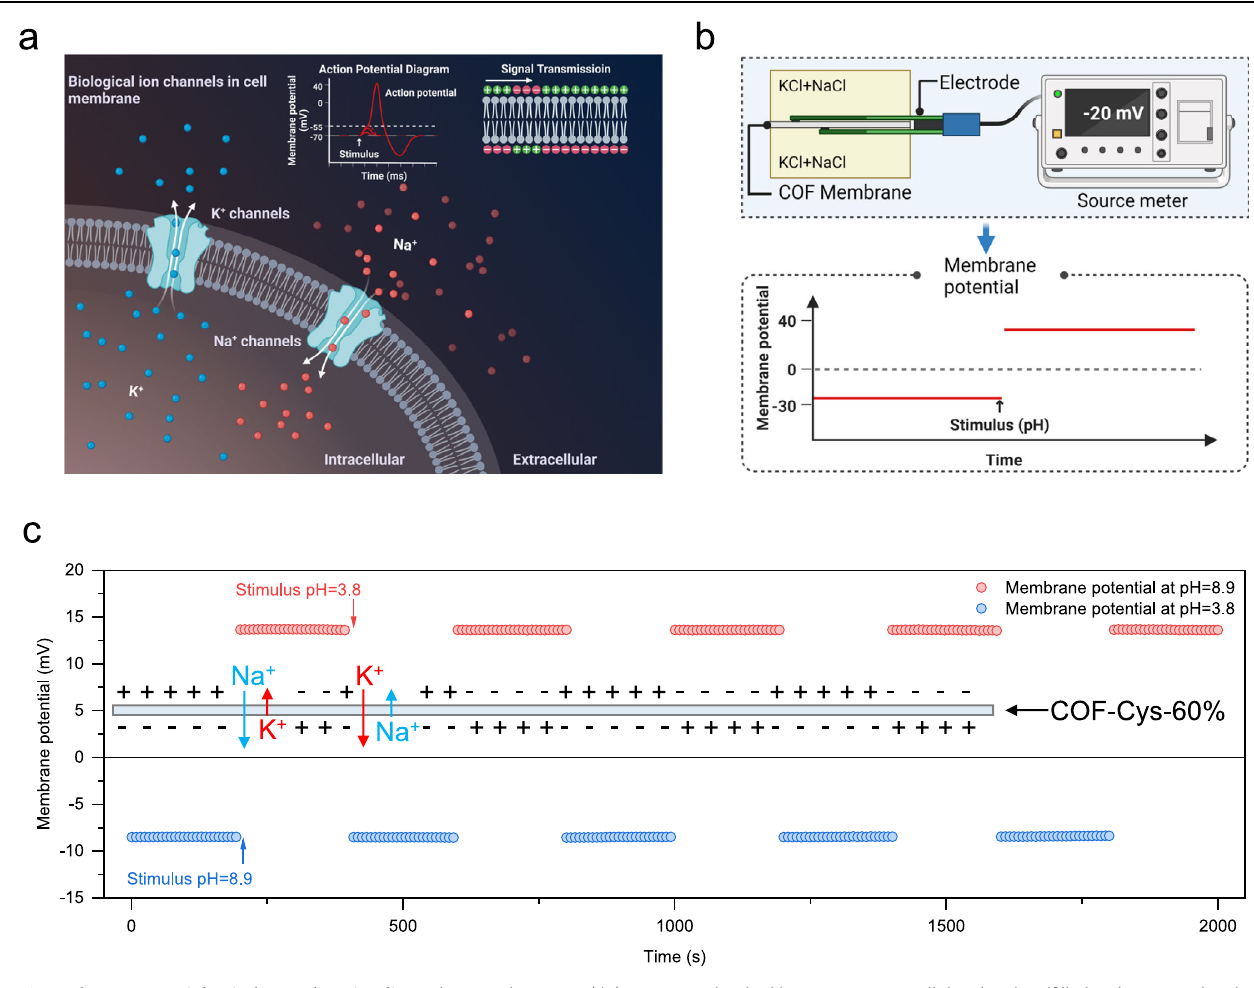
was sandwiched between an intracellular chamber ( fi lled with 0.1M KCl and 5mM NaCl) and an extracellular chamber ( fi lled with 0.1M NaCl and 5mM KCl). The membrane potential was recorded using a source meter. c Membrane potential switches when a stimulus is applied